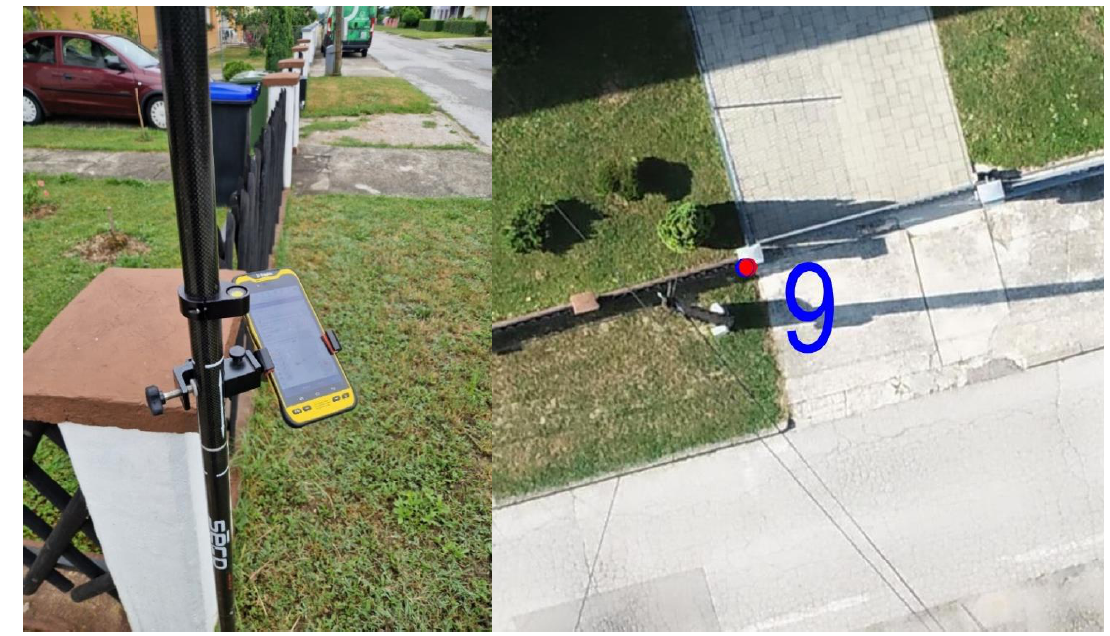
Figure 13. Concrete fence with a post cap in the field ( left ); Vectorized fence point shown on the DOF map with red and GNSS RTK measured point with blue colour ( right ).